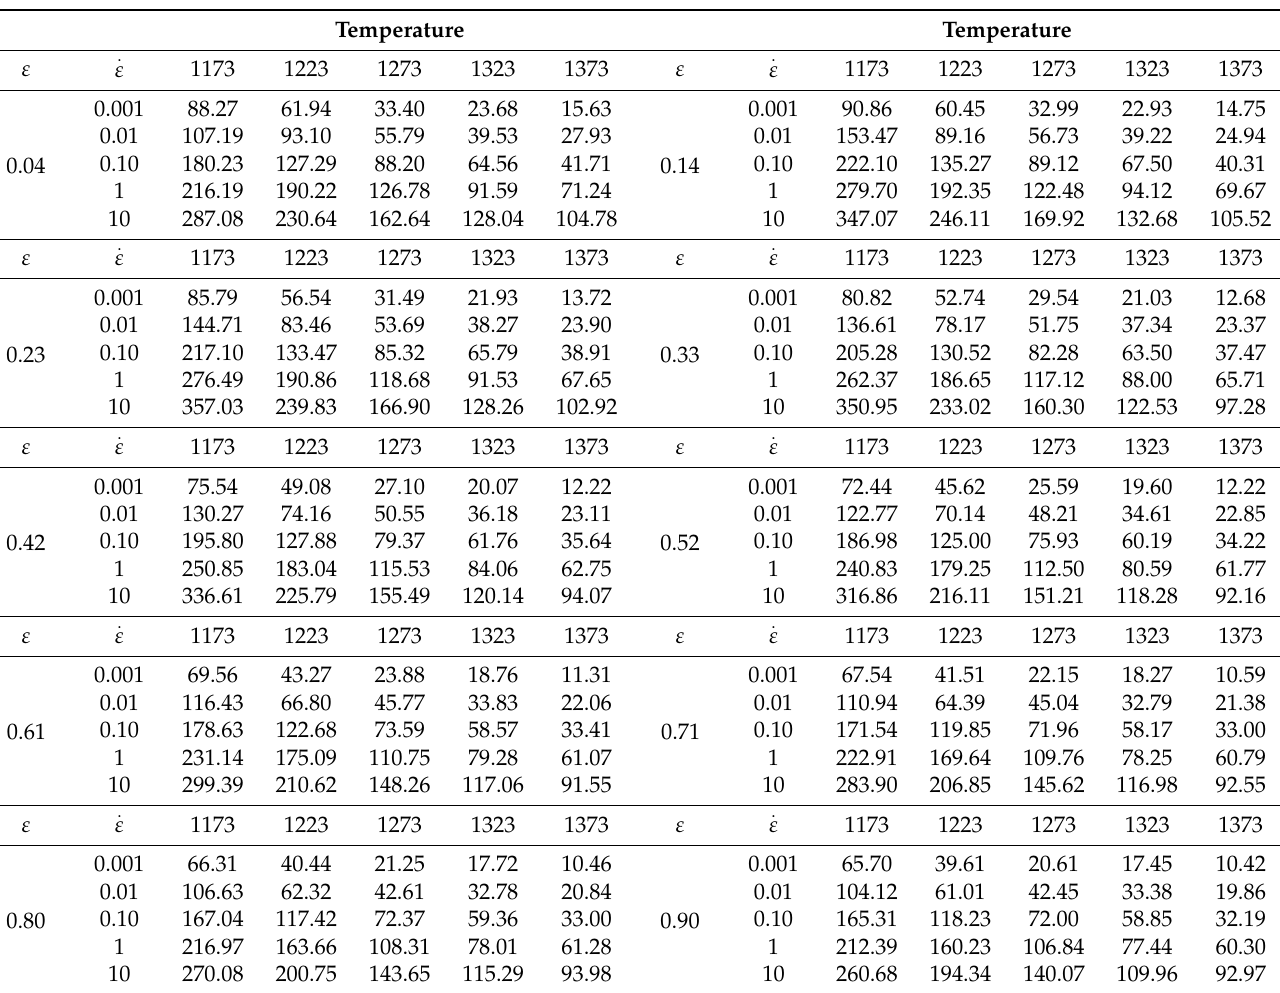
Table 3. Stress matrix corresponding to different strain levels (The units of strain rate, temperature and stress are s − 1 , K and MPa,